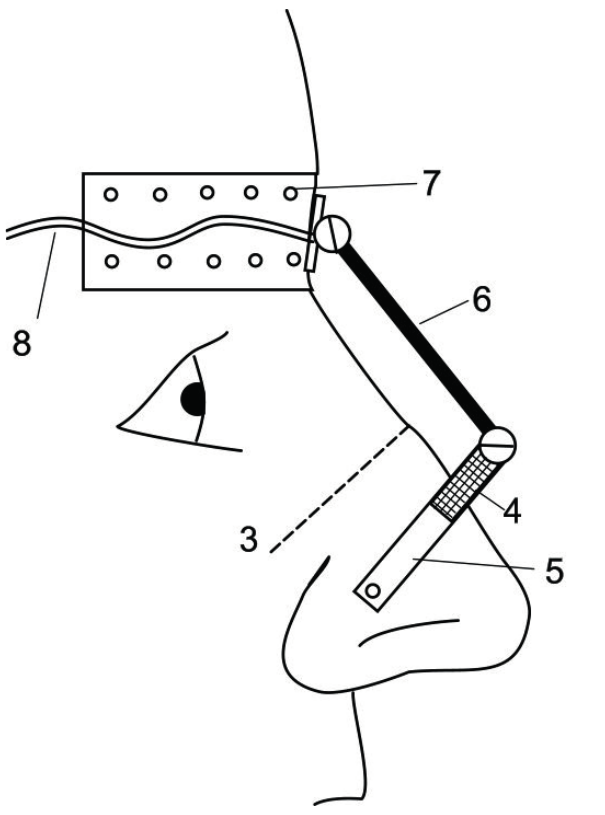
Figure 1. Scheme of nasal valve elastography (from Vogt and Prill 2018 [13]). Border between soft and hard tissue of the nose (3); Fixating ele- ment attached to a headband (7); Mechanical connection piece (6); Feather strip on which (5); Strain gauges on both sides (4); Connection to the electric measurement bridge